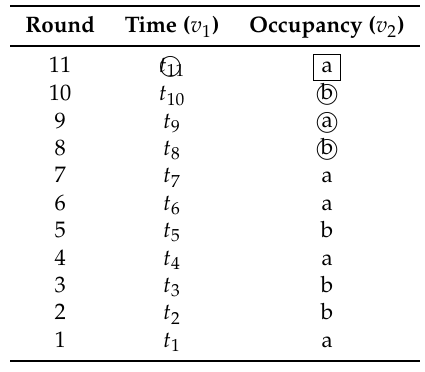
Table 3. A sequence and mask for a system with uncertain output. Circles are input data for the function f and the square is the output data.